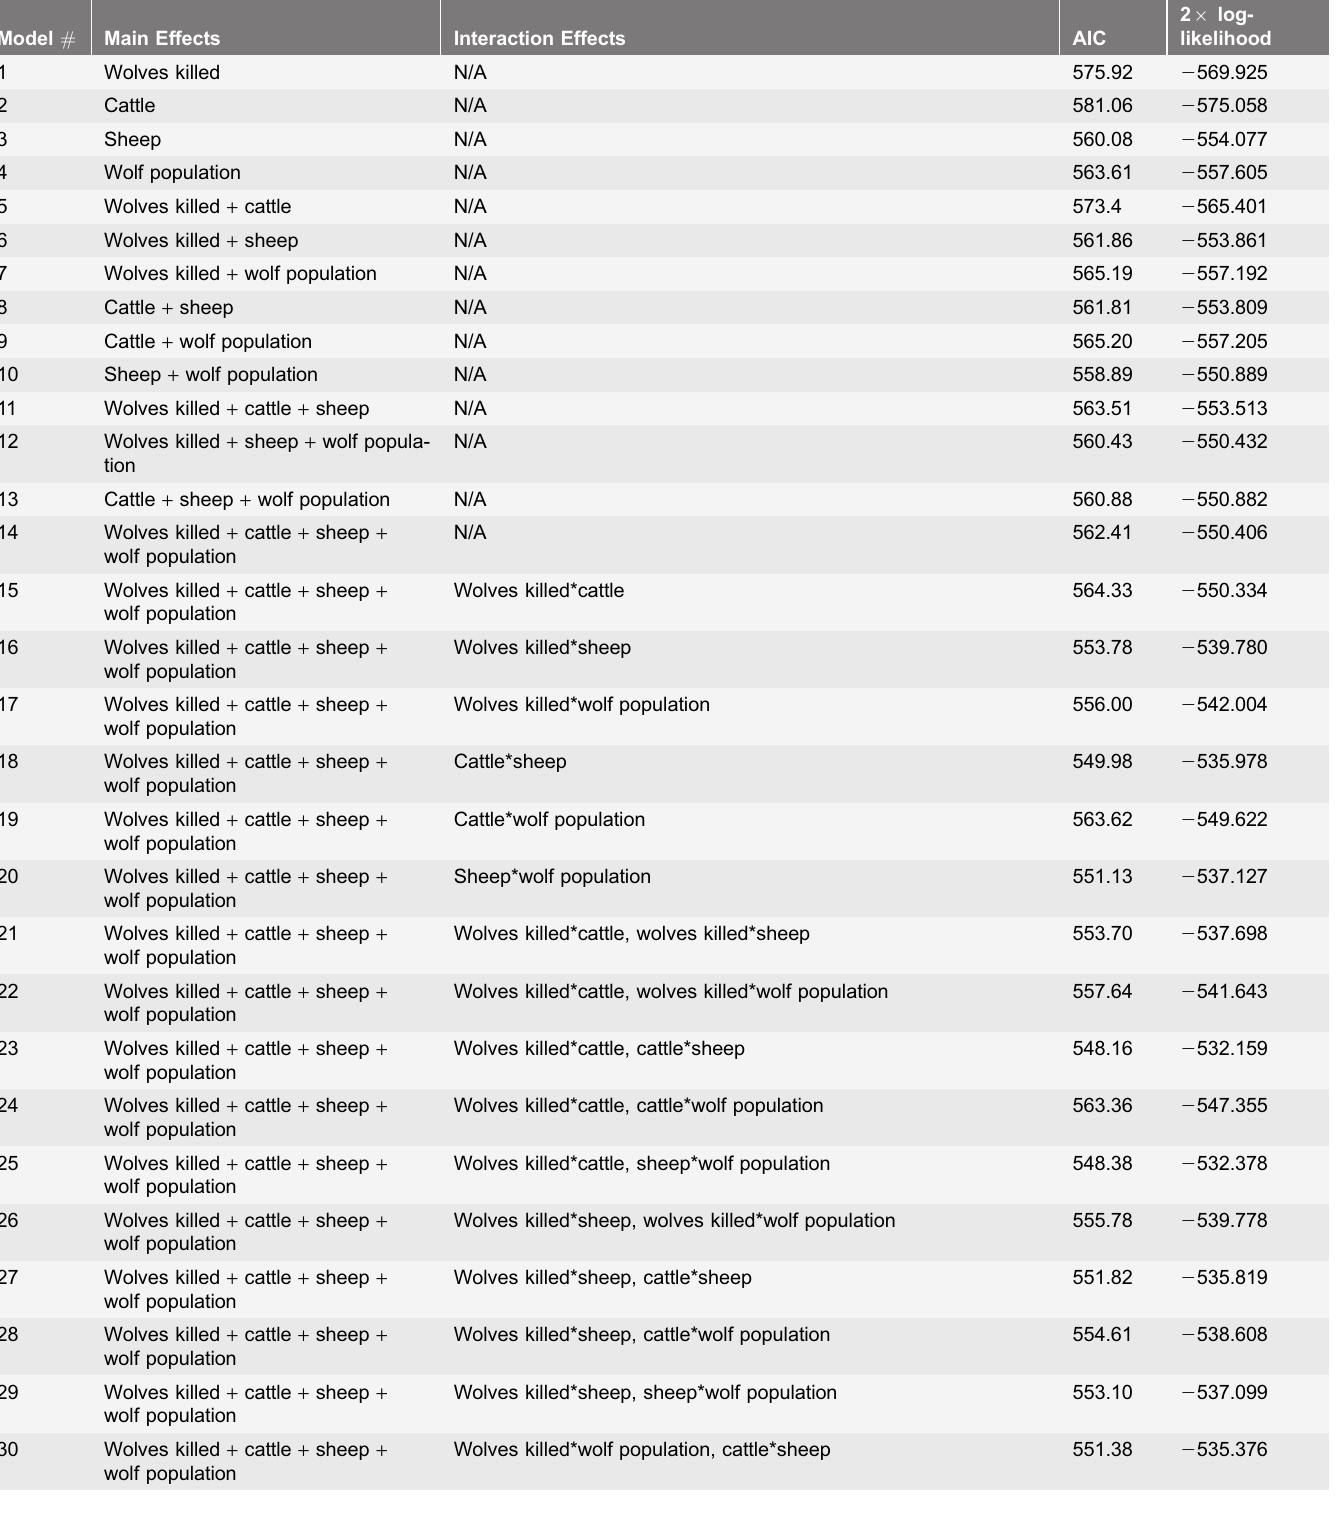
Table 3. AIC and log-likelihood values for forward selection of main effects and interaction effects models of sheep depredations. Model